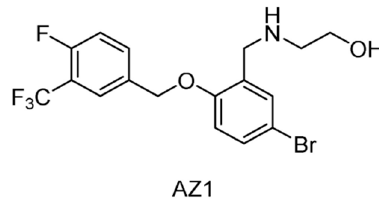
Figure 25. Structure of compound AZ1.